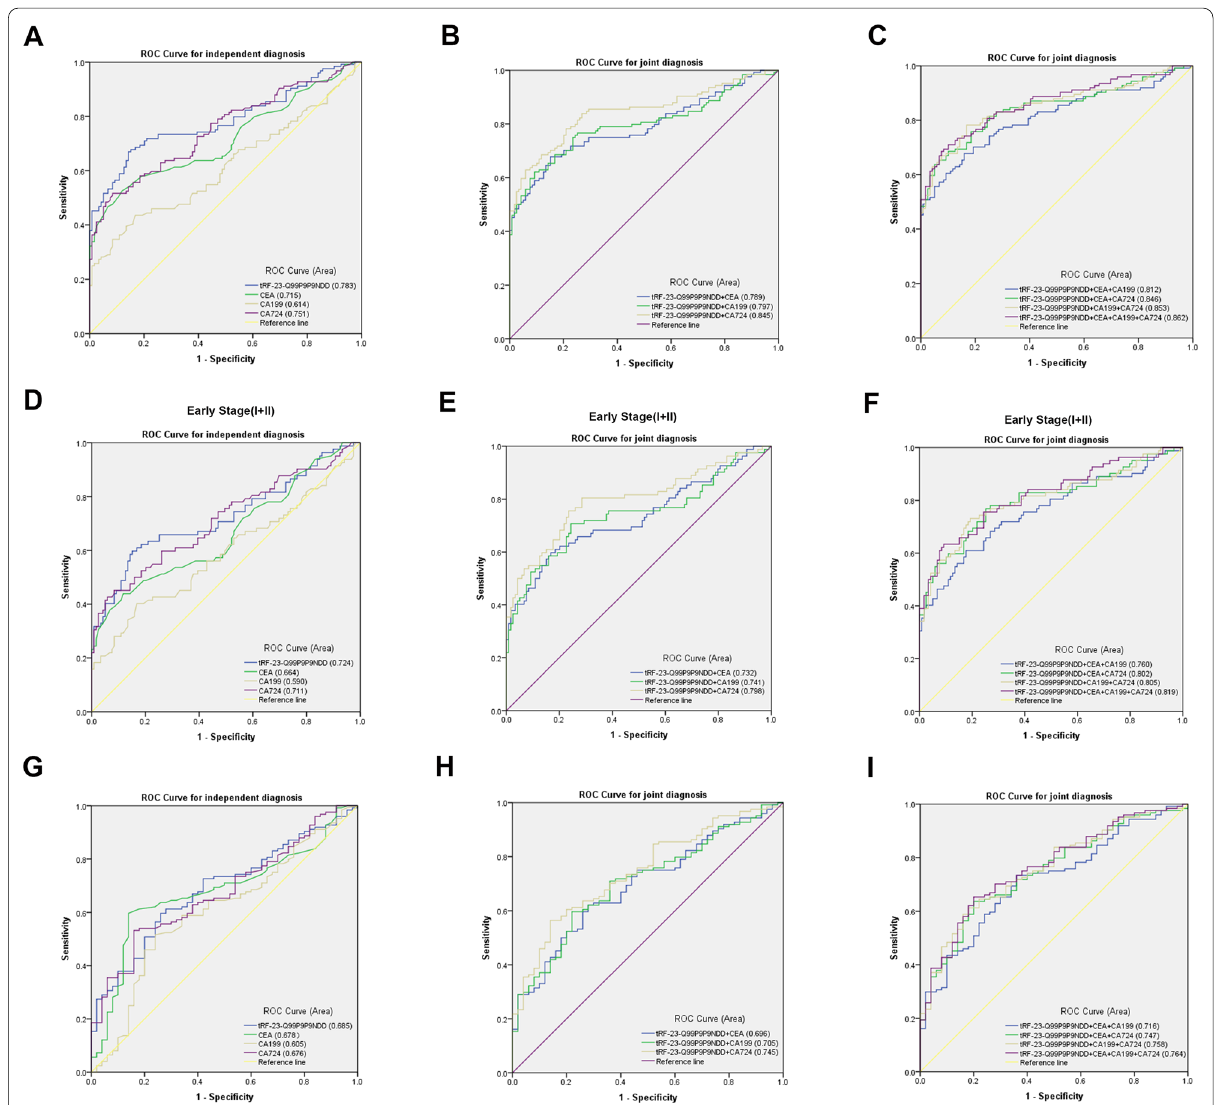
Fig. 5 Diagnostic value of serum tRF-23-Q99P9P9NDD for GC. A – C The diagnostic efficacy of tRF-23-Q99P9P9NDD, CEA, CA199, and CA724 in differentiating GC patients from healthy donors. D – F The diagnostic efficacy of tRF-23-Q99P9P9NDD, CEA, CA199, and CA724 in differentiating early GC patients from healthy donors was determined by ROC analysis. G – I The diagnostic efficacy of tRF-23-Q99P9P9NDD, CEA, CA199, and CA724 in differentiating GC patients from gastritis patients was determined by ROC